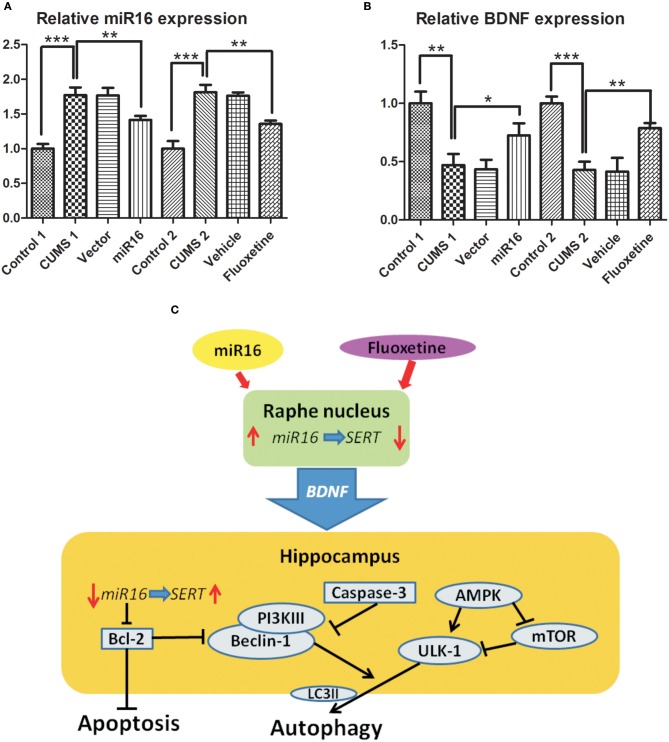
Hypothetical diagram of miR-16 and BDNF network regulation through autophagy and apoptosis. miR-16 and Fluoxetine treatment at the Raphe nucleus can generate autophagic and apoptotic changes in the hippocampus through regulation of BDNF. Histograms show relative expression of miR-16 (A) and BDNF (B) from RT-PCR. Values are the means ± SEMs. *P < 0.05; **P < 0.001; ***P < 0.0001. (C) Hypothetical diagram of how the miR-16 and BDNF networks regulate autophagy and apoptosis. Fluoxetine and miR-16 injection into the Raphe nucleus presented protective effects on CUMS derived depressive symptoms and that in both cases this is done by regulating BDNF expression via miR-16 in the hippocampus.